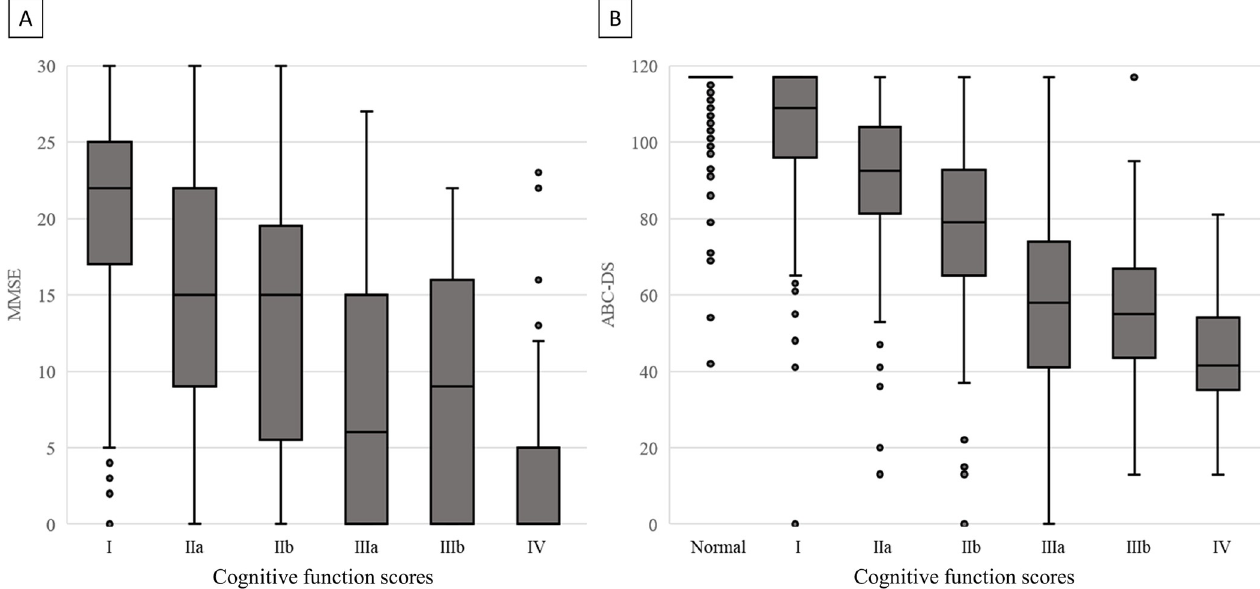
Fig 3. Box and whisker diagrams showing the relationship between CFS and (A) MMSE, and (B) ABC-DS. The Spearman’s rank correlation coefficient between Cognitive Function Score and Mini-Mental State Examination was − 0.546, p < 0.001 (A), and that between Cognitive Function Score and ABC Dementia Scale was − 0.862, p < 0.001